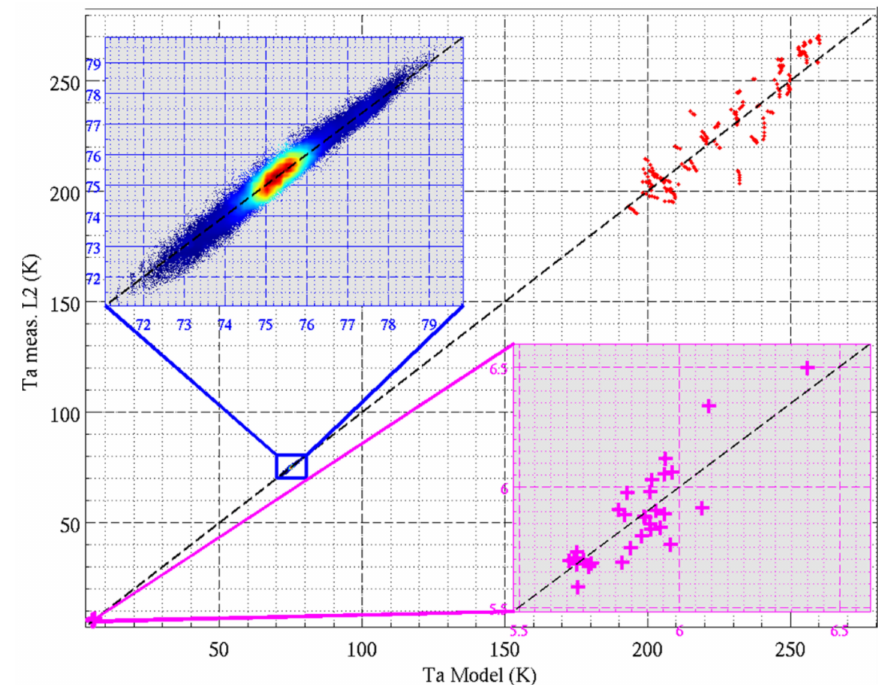
Figure 11. Aquarius measured antenna temperature, Ta_measured, plotted against the antenna temperature predicted with the forward model, Ta_model, for three regimes: cold sky (magenta insert), ocean (blue insert), and Little Washita watershed (red dots). The data are for the outer Aquarius beam and horizontal polarizations, and Version 5.WR, the final release of the algorithm with the full range calibration. Insets are close-ups of ocean and Sky